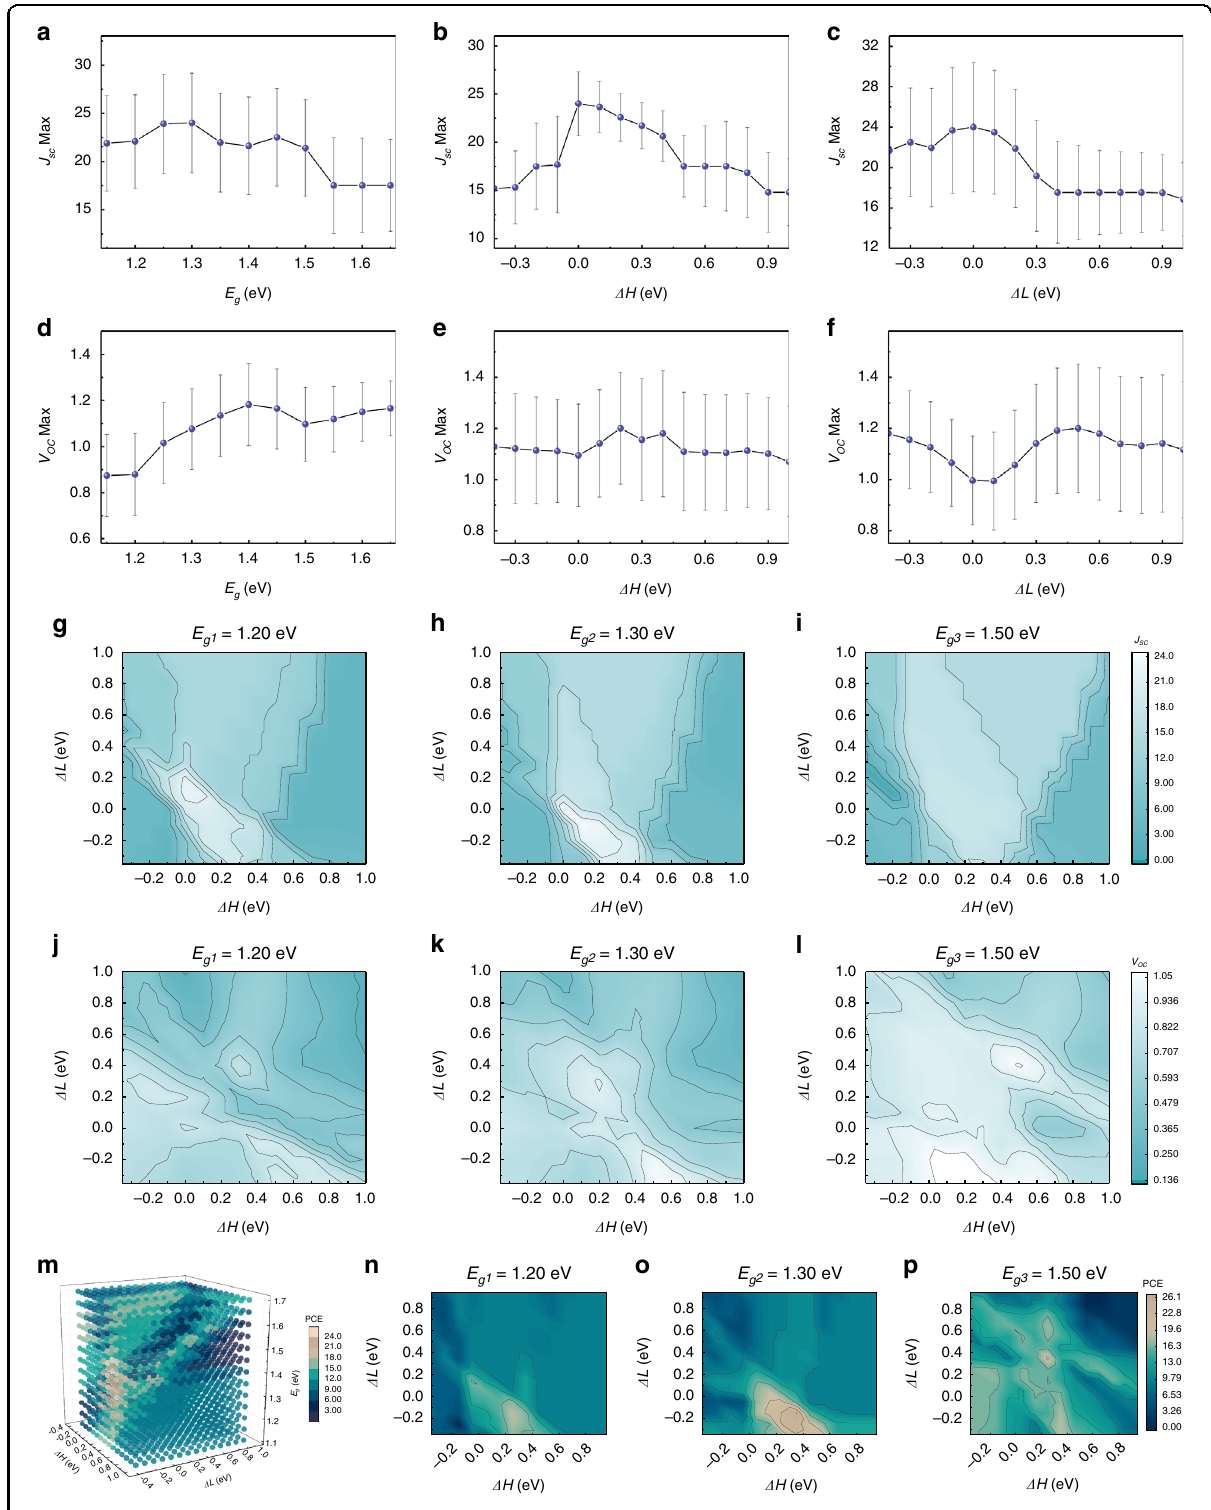
Fig. 3 Further analysis of PSCs performance behind NN model with three parameters as input (the E g of OMHP material, the energy difference Δ H and Δ L ). a The maximum J sc versus E g ; b the maximum J sc versus Δ H ; c the maximum J sc versus Δ L ; d the maximum V oc versus E g ; e the maximum V oc versus Δ H ; f the maximum V oc versus Δ L . 2D-contour map of J sc predictions at g E g1 ; h E g2 ; i E g3 , and 2D-contour map of V oc predictions at j E g1 ; k E g2 ; l E g3 . m 4D-scatter plot of PCE with respect to E g , Δ H , and Δ L exhibiting that the highest PCE value is in the range of 1.30 eV to 1.40 eV. 2D-contour map of PCE predictions at n E g1 ; o E g2 ; p E g3 . Here, E g1 = 1.20 eV, E g2 = 1.30 eV, and E g3 = 1.50